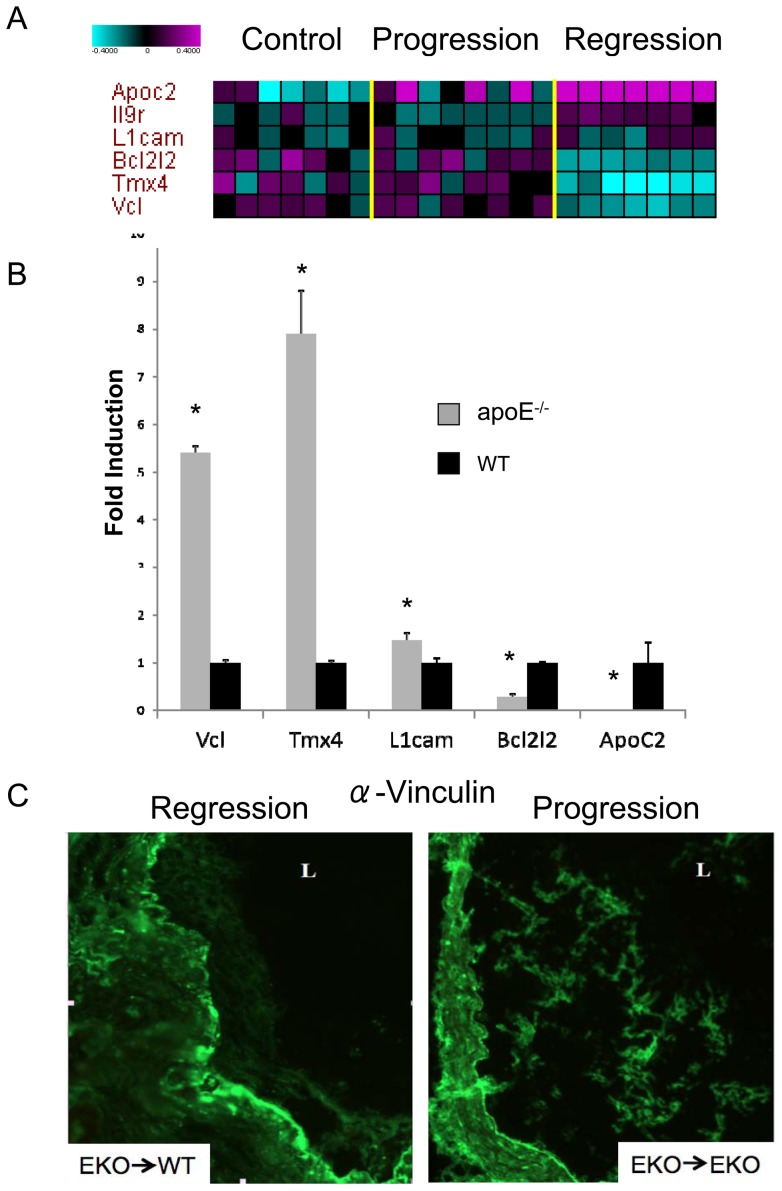
Multivariate causal pathway analysis for genes involved in regression.(A) Heatmap displaying the relative levels of the 6 genes selected by HITON-PC algorithm for causal relationship to regression vs. progression/baseline task (Y-axis) in each of the 22 analyzed aortic samples (X-axis). B) RNA was isolated from laser captured CD68+ cells. qPCR was then performed in order to validate microarray results. The symbol * corresponds to statistical significance, p<0.05, when signal in RNA from aortas in regression (apoE −/−) was compared to signal in RNA from aortas in progression (WT). 9 mice were analyzed per group. GAPDH was used for normalization. C) Immunostaining for vinculin in a plaque derived from an aortic arch transplanted from an apoE−/− mouse into a wild type normolipidemic mouse (apoE−/− > WT) and from an apoE−/− mouse into a different apoE−/− mouse (apoE−/− > apoE−/−).